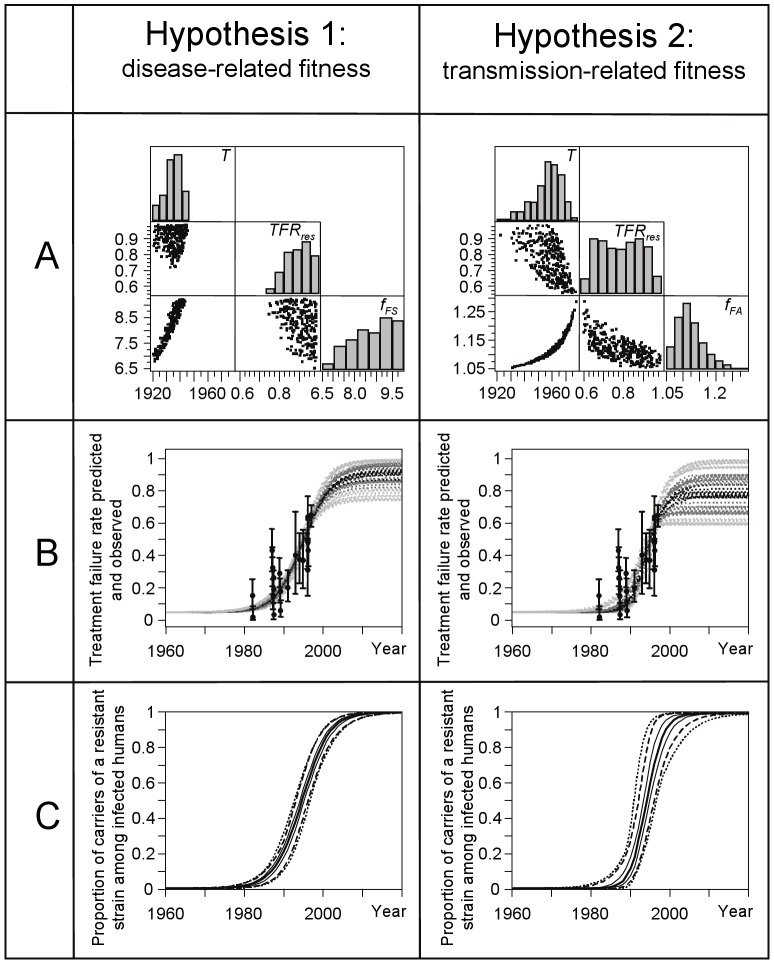
Analyses on the effects of parameter variations on the treatment failure rates observed in Bihar.Two hypotheses on increased fitness in resistant parasites are compared in three panels A, B, C. Panel A) the distributions of and correlations between T (the year when first resistance has emerged), TFRres (the treatment failure rate of patients infected with the resistant strain) and fFS (the disease-related fitness factor) or fFA (the transmission-related fitness factor). Panel B) the simulated overall TFR predicted by the model together with the data based observed TFR and their 95% confidence intervals. Panel C) the predicted proportions of resistant infections among all infections. In panel B and C, distributions of the hypothesis-specific predictions are represented by the minimum, by quantiles 2.5%, 25%, 50%, 75%, and 97.5%, and by the maximum. Model predictions are extrapolated until 2020 under the assumption of an unchanged antimonial treatment schedule.